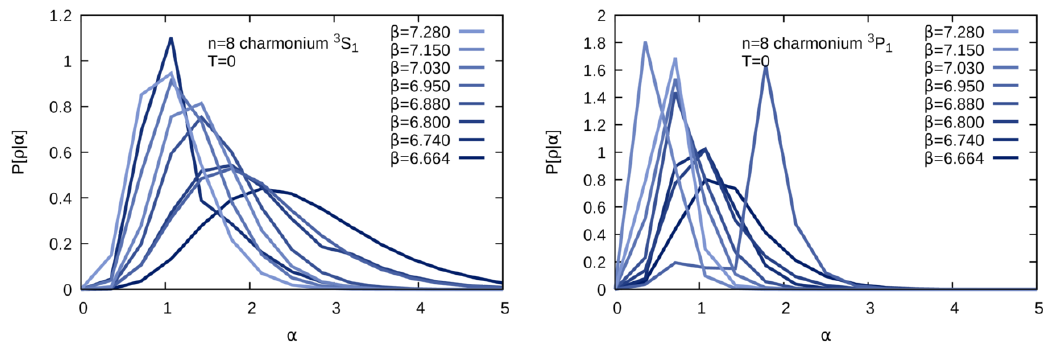
Figure 32 . Representative examples of the probability distribution over the hyperparameter (cid:11) used in the self consistent determination of the most probable spectrum at zero temperatures. We show here charmonium results, the left panel contains the S-wave results, the right panel the P-wave channel.